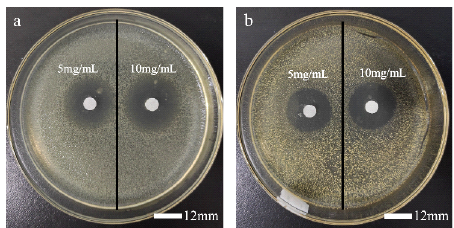
Figure 4. Inhibition zone of E. coli ( a ) and S. aureus ( b ) treated with GT.